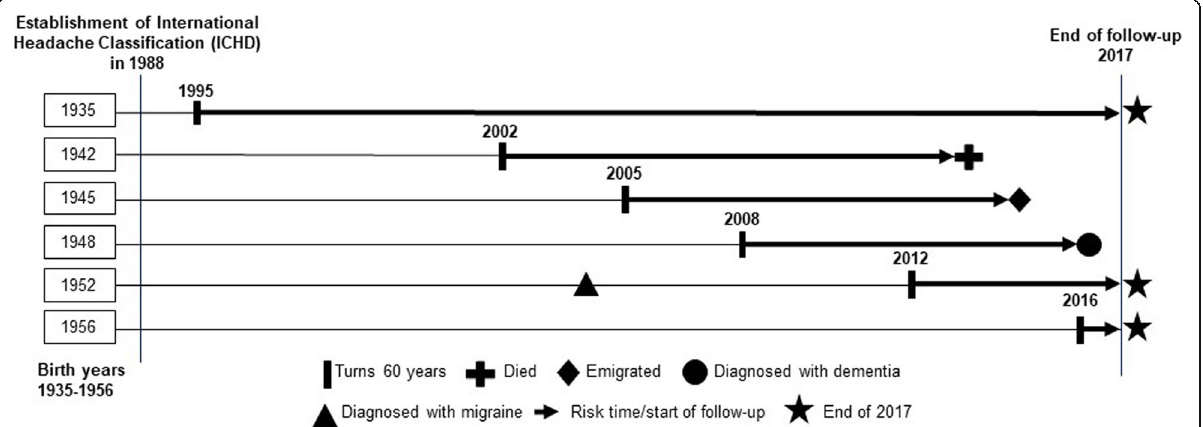
Fig. 1 Study design. Birth cohorts born between 1935 and 1956 are illustrated from 1988 to 2017. Individuals were followed from when they turned 60 years until death, emigration, dementia diagnosis, or end of follow-up in 2017. Migraine diagnoses were registered from 1988 onwards.